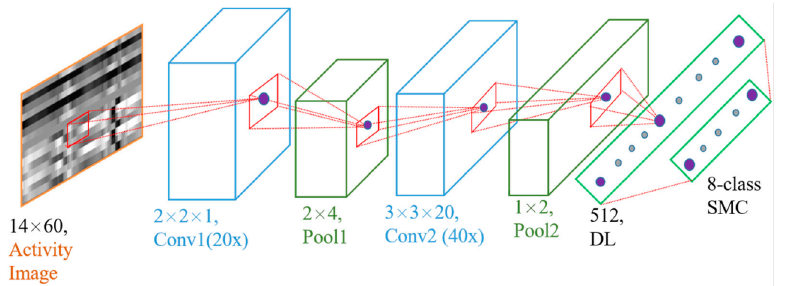
Figure 10. SC-CNN model. Conv = convolution layer, pool = pooling layer, DL = dense layer (fully connected), and SMC = softmax